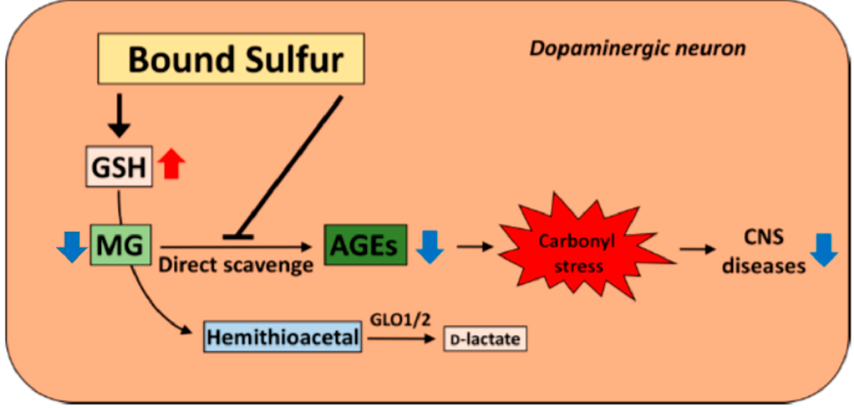
Figure 4. Proposed mechanisms of the protective effects of polysulfides against carbonyl stress in neuronal cells. MG: methylglyoxal; GLO: glyoxalase; AGE: advanced glycation end product, CNS: central nervous system.